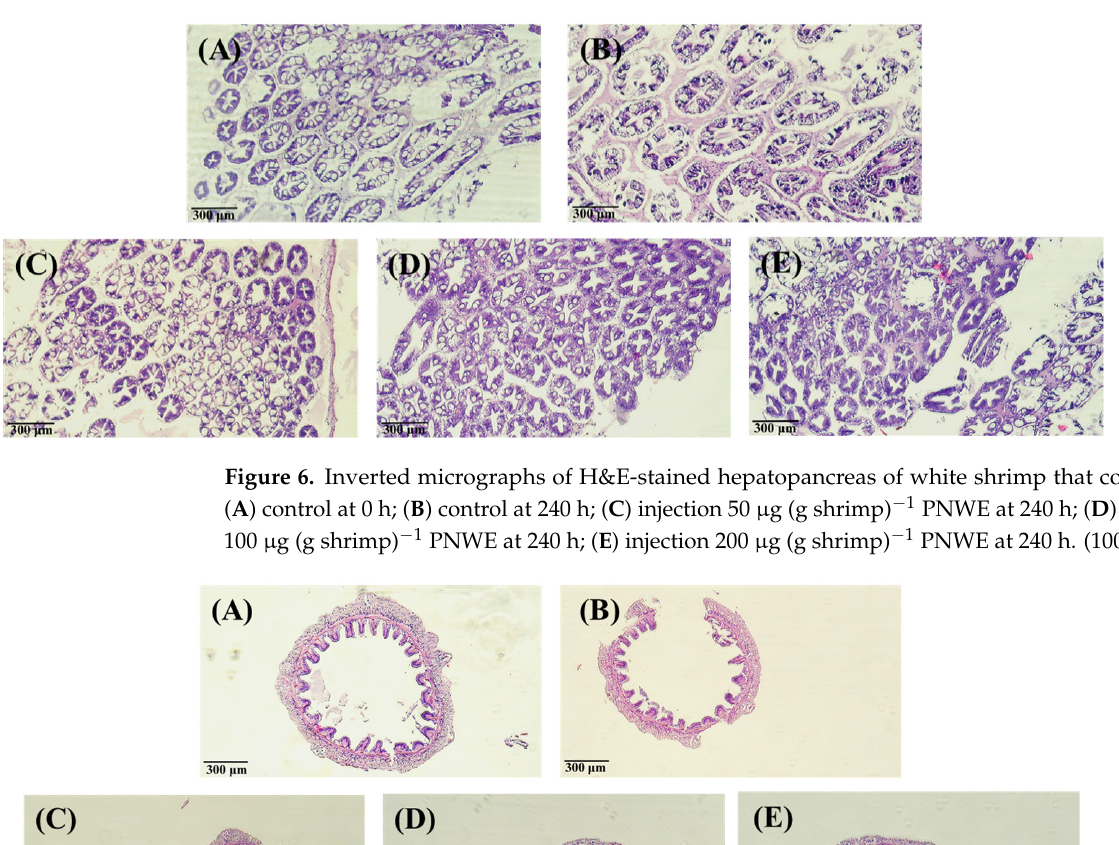
( D ) Figure 5. Trypsin ( A ), chymotrypsin ( B ), amylase ( C ), and Lipase ( D ) activity of Litopenaeus vannamei that received the water extract of Panax notoginseng at 50, 100, and 200 μ g (g shrimp) − 1 and control shrimp. Data are expressed as mean ± SD ( n = 8). Different superscript letters indicate that the same exposure time significantly differs ( p < 0.05) among groups (Duncan’s multiple range tests). 3.3. Effect of PNWE on the Variation in Vibrio Number and Histologic Patterns of L. vannamei As shown in Figures 6 and 7, after 240 h, the hepatopancreas and intestine histology of L . vannamei injected with different concentrations of the PNWE did not differ signifi- cantly from the control.